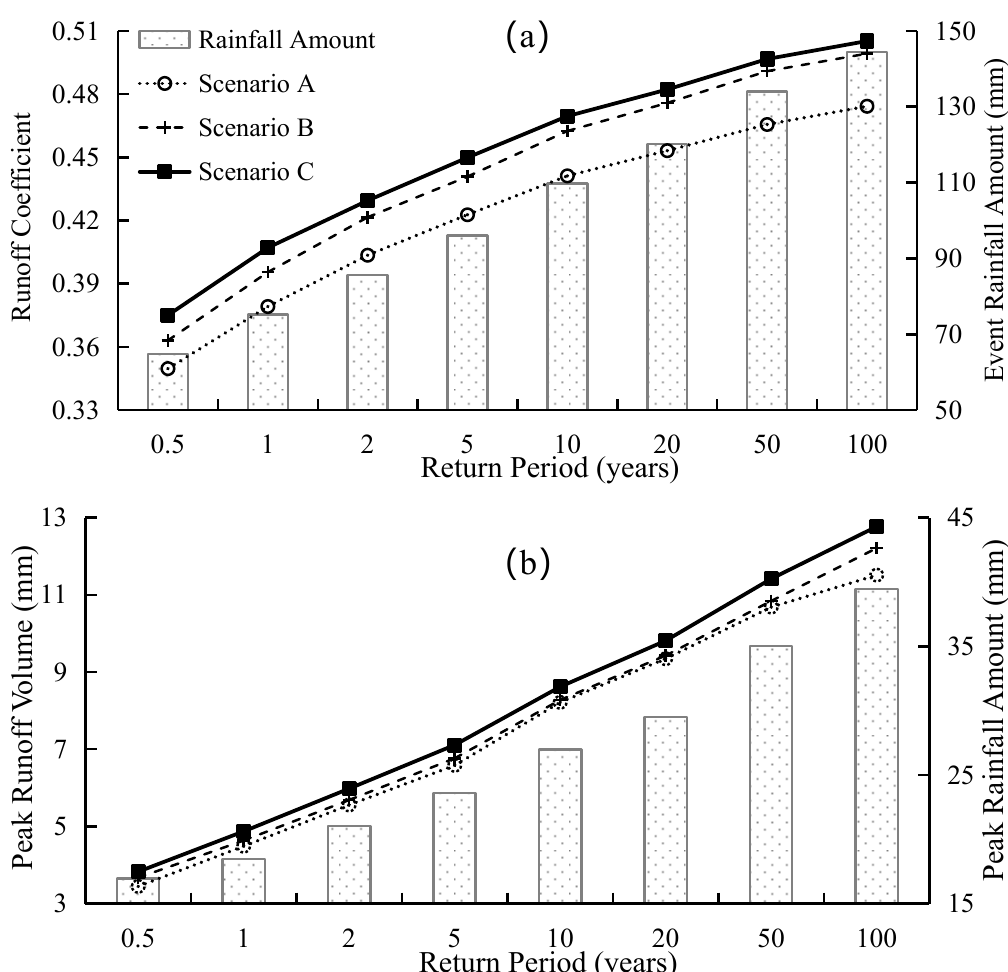
Figure 5. The runoff coefficients ( a ) and peak runoff volumes ( b ) simulated in SWMM under the storms in Group I.